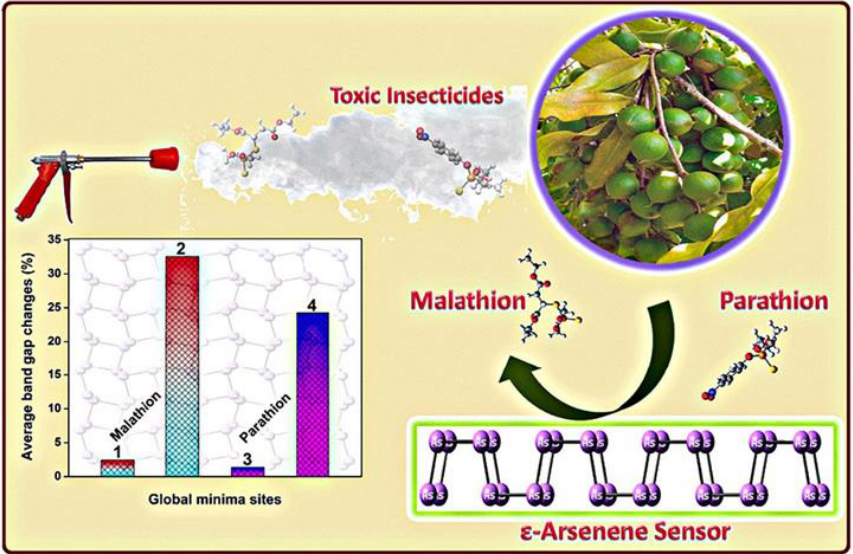
Figure 8. Detection of ethyl parathion — chemiresistive approach. Reprinted with permission from [51].